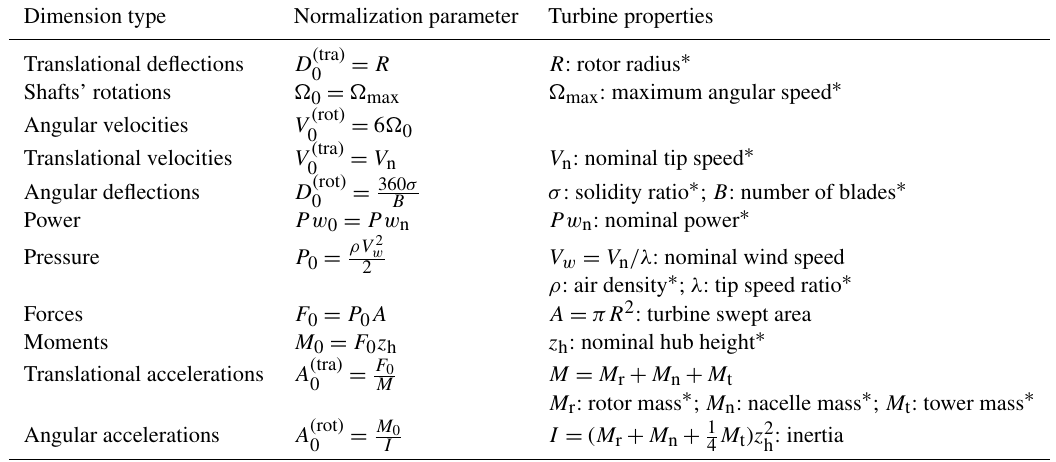
Table 1. Normalization parameters. Values of turbine properties were obtained from Malcolm and Hansen (2006). Dimension type Normalization parameter Turbine